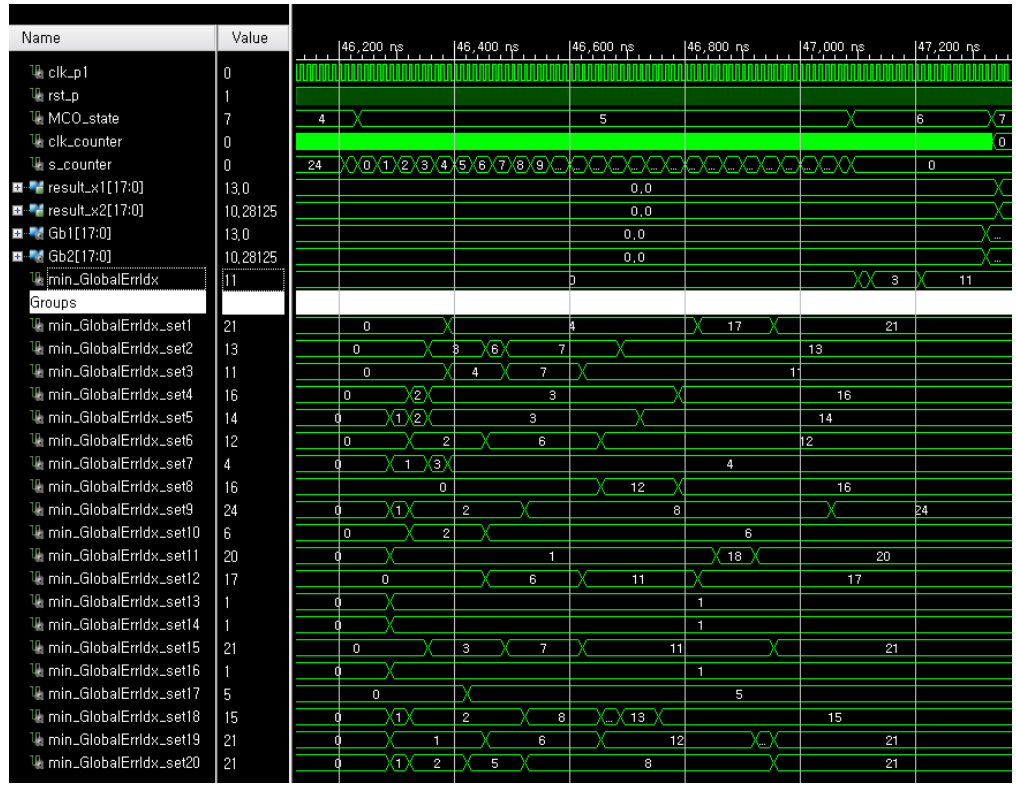
Figure 7. The detailed simulation results of finding, respectively, the best group and the best configuration at the MCO_state 5 and 6 in the FRMCO with 500 samples in 20 groups when α = 0.